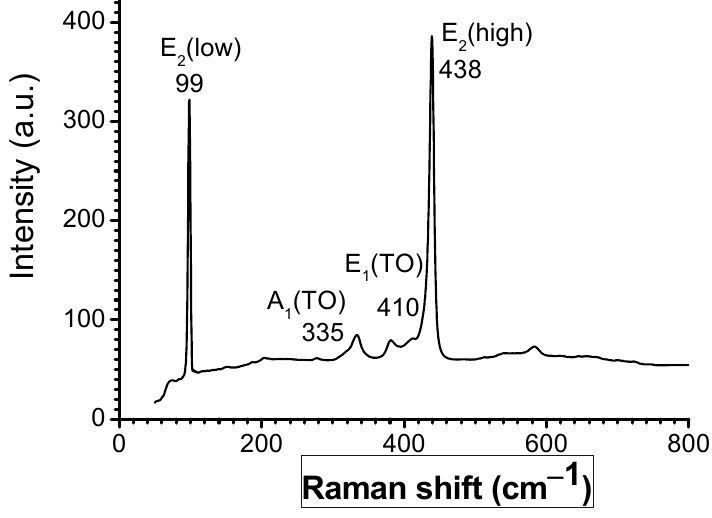
Figure 3. Room temperature Raman spectra of ZnO NR array grown on a quartz substrate.